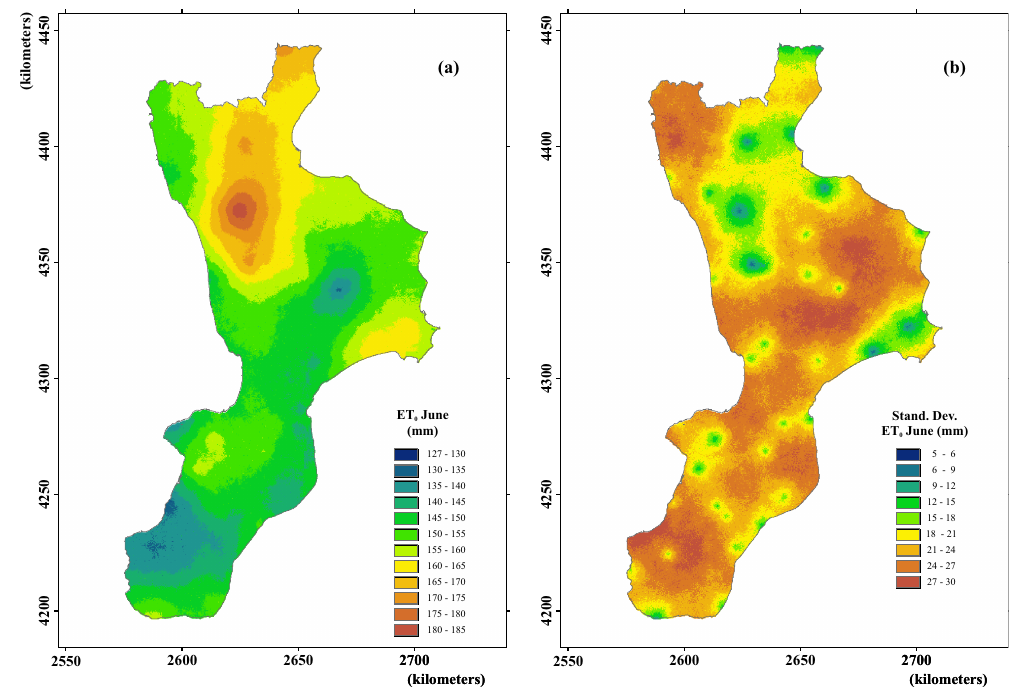
Fig. 4. Mean (a) and standard deviation (b) maps of simulations for ET 0 .